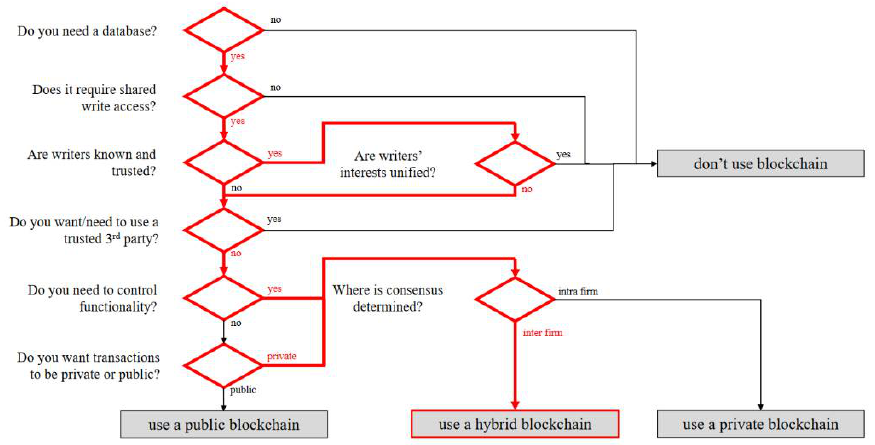
Figure 8. Blockchain user criterion. Reprinted/Adapted with permission from Reference [71]. Cop- yright 2017 Copyright Elsevier Ltd.